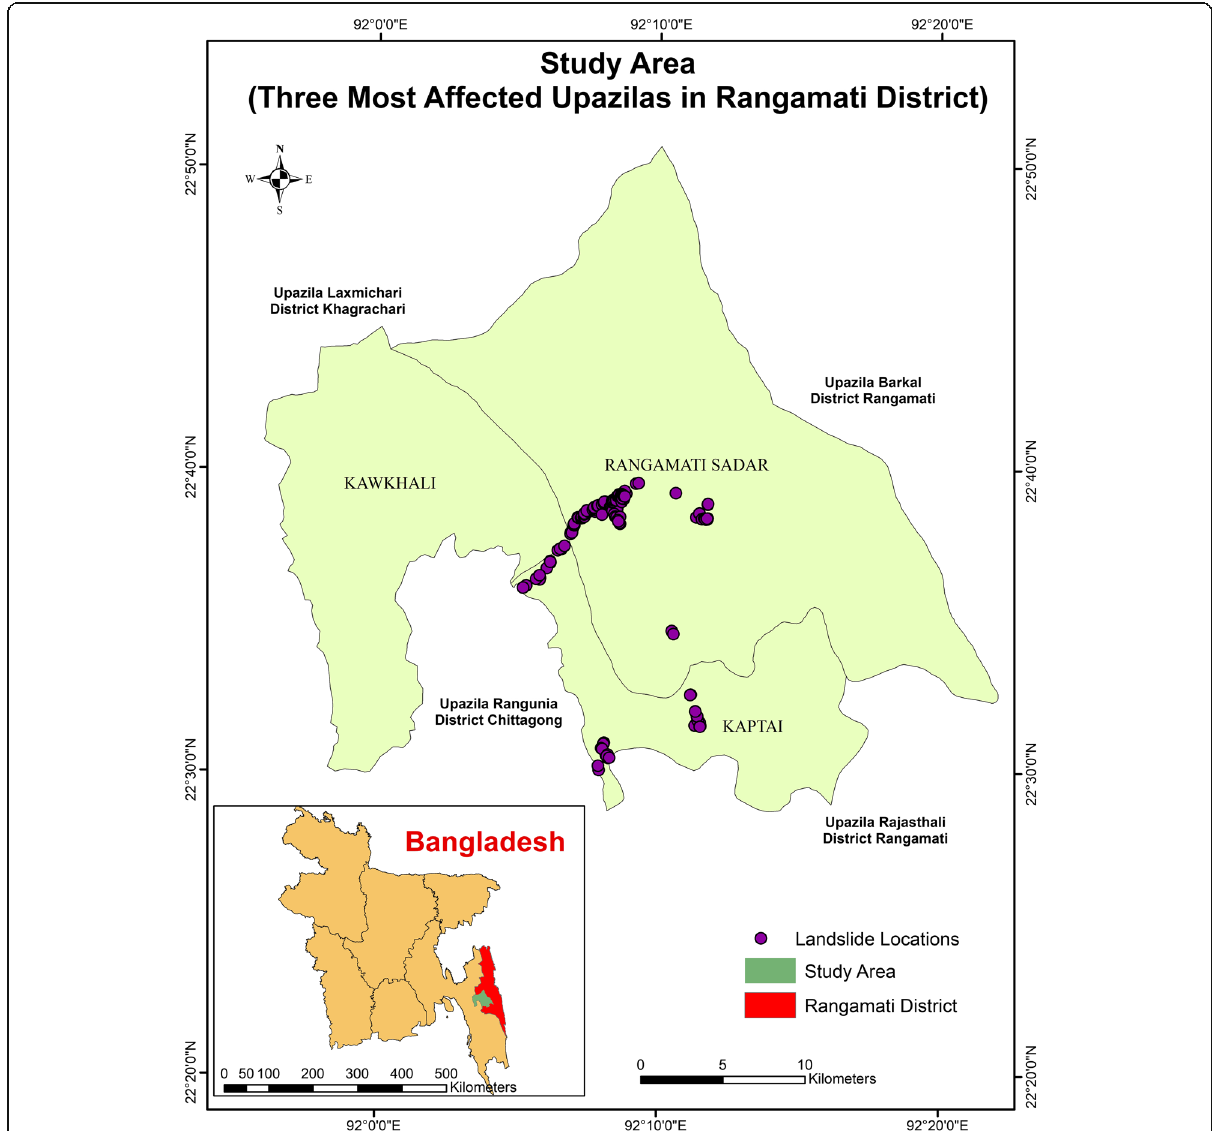
Fig. 1 Map of the Study Area and the Locations of